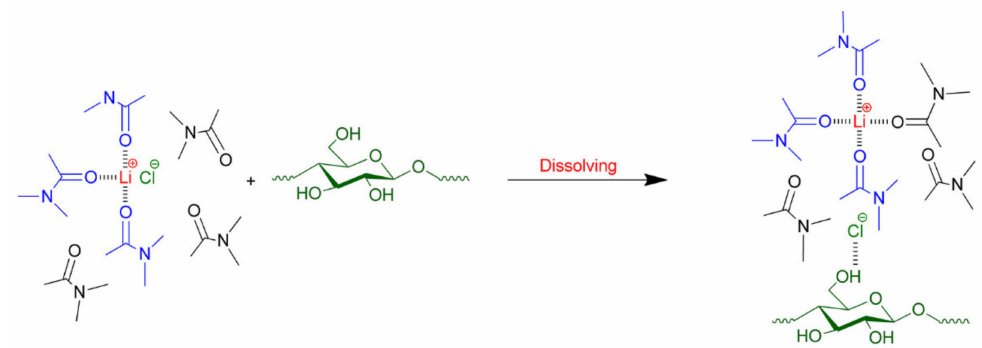
Figure 4. Interaction of cellulose with Li + cations, Cl − anions, and DMAc during its dissolution in the DMAc/LiCl solvent system, proposed by Zhang et al., 2014. Reprinted with permission from [35] © 2021 American Chemical